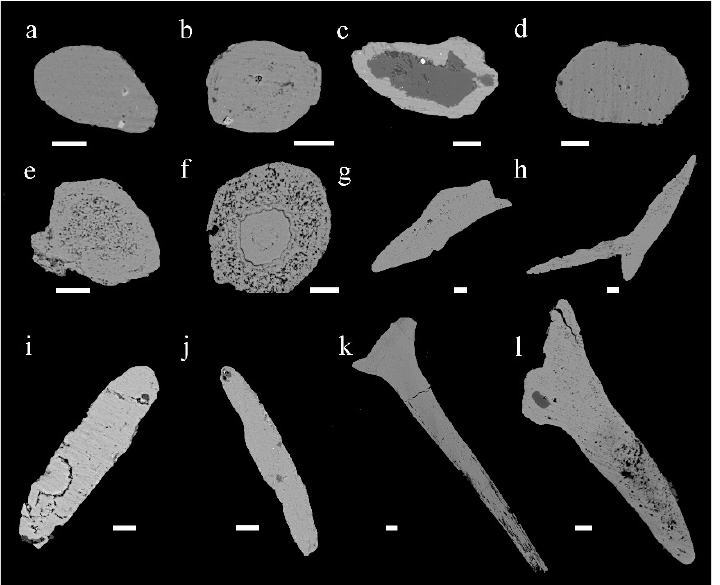
Figure 4. Different back-scattered electron images (BSE) of francolite in the Zhijin phosphorites. Each scale bar shown inset represents 20 μm. ( a – d ) Granular francolite; ( e – l ) bioclastic francolite; ( e , f ) the cross section of the bioclastic francolite.